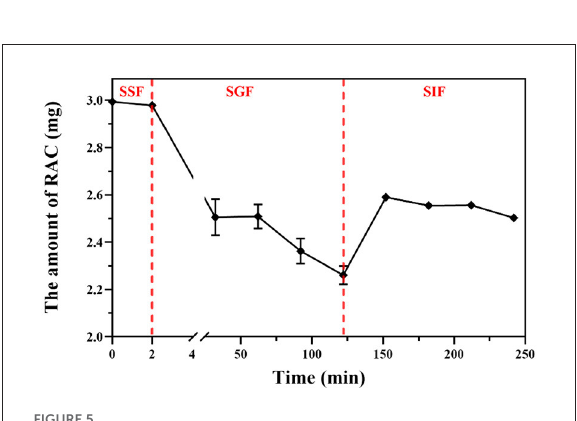
FIGURE5 The amount of residual RAC during simulated oral (SSF), gastric (SGF), and intestinal (SIF) digestion in vitro